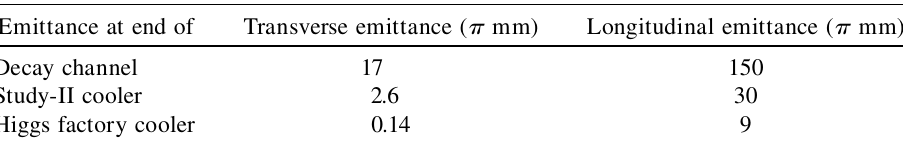
TABLE XIII. Transverse and longitudinal emittances at the end of the decay channel, study- II cooling channel, and the Higgs factory cooling channel.